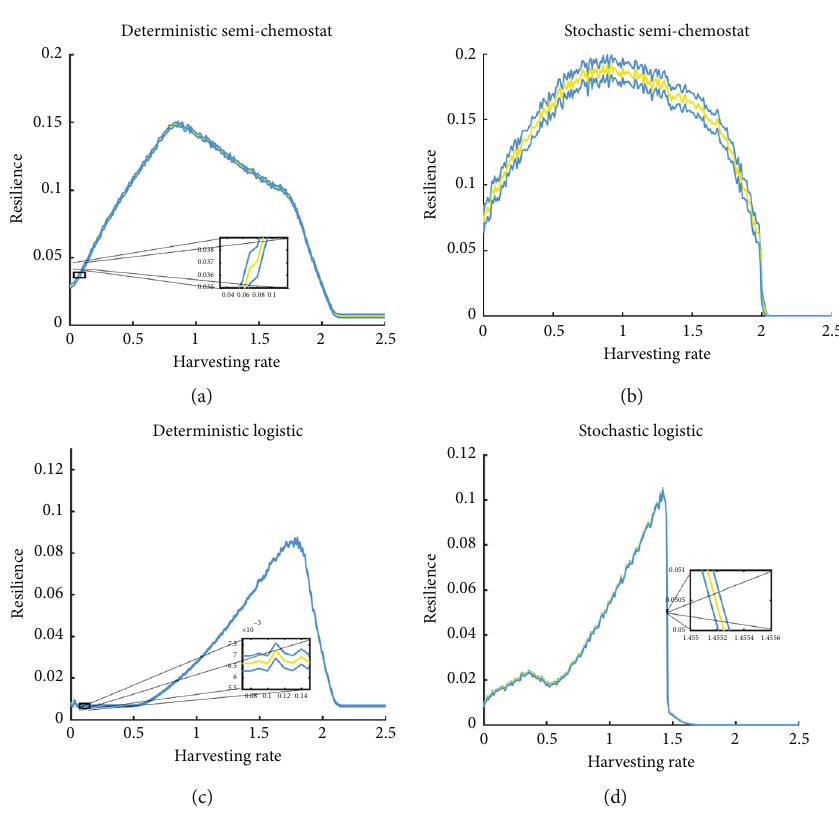
Figure 4: The resilience for deterministic (a, c) and stochastic (b, d) growth rates is calculated by using the algorithm described in Appendix B.1. The mean (yellow curve) and the standard deviation (68%) (light blue curves) of the resilience are shown for all